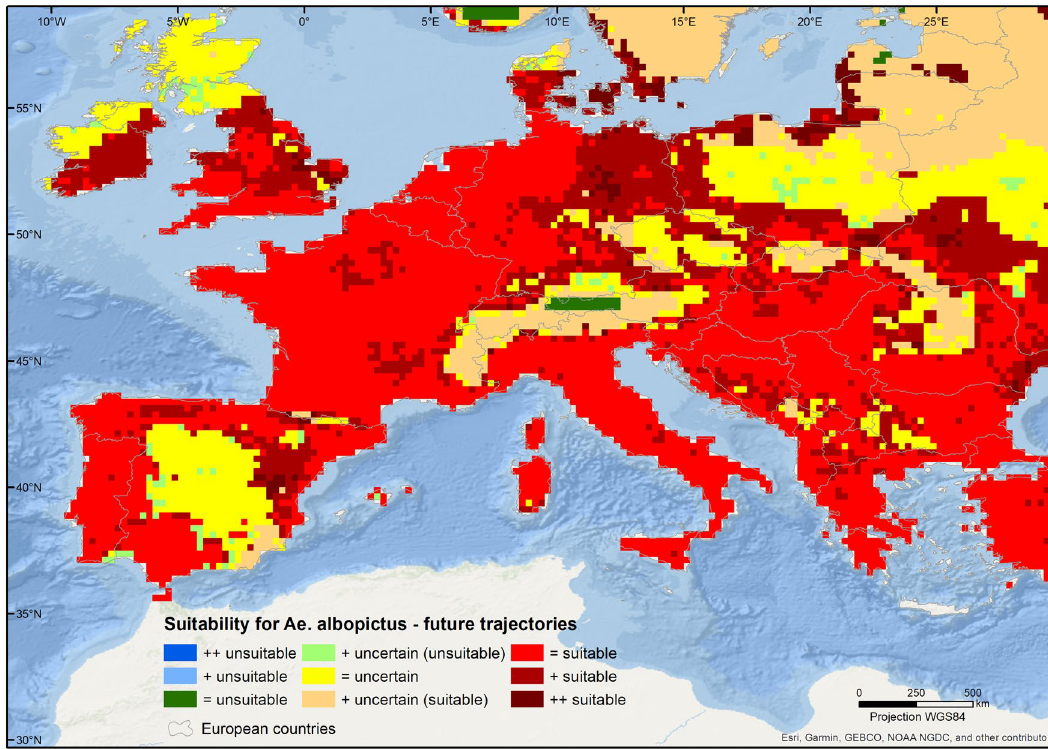
Figure 3. Future trajectories of suitability for Aedes albopictus in Europe. Each trajectory represents a different combination of predicted status (suitable, uncertain, unsuitable) in the two timeframes (present and future). The map was created using ArcGIS v. 10.6.1 (https:// www. arcgis.